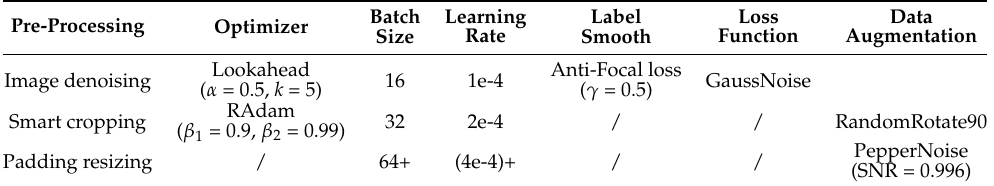
Table 2. Strategies used in the training